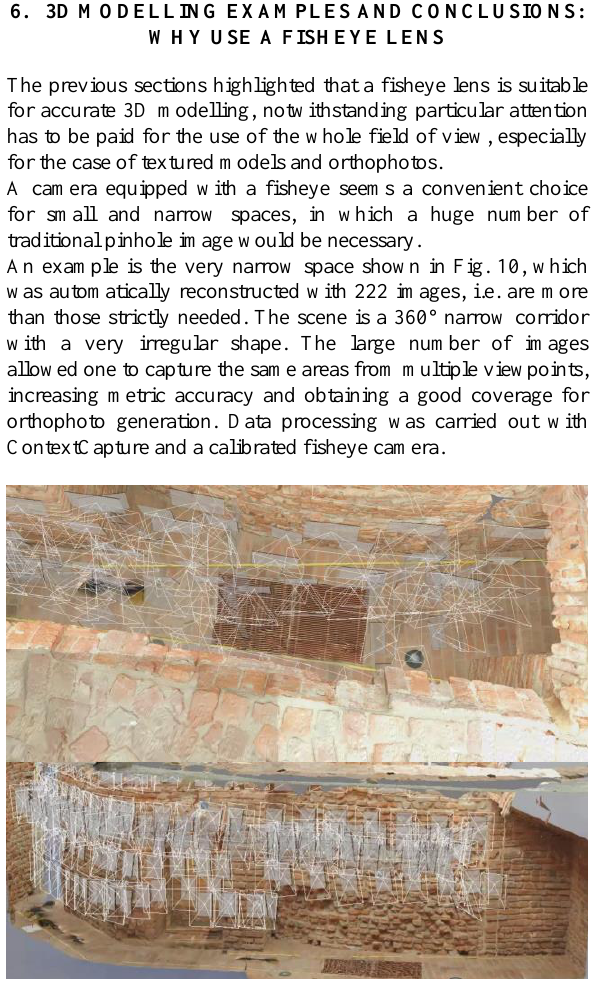
Figure 10. A narrow scene reconstructed with 222